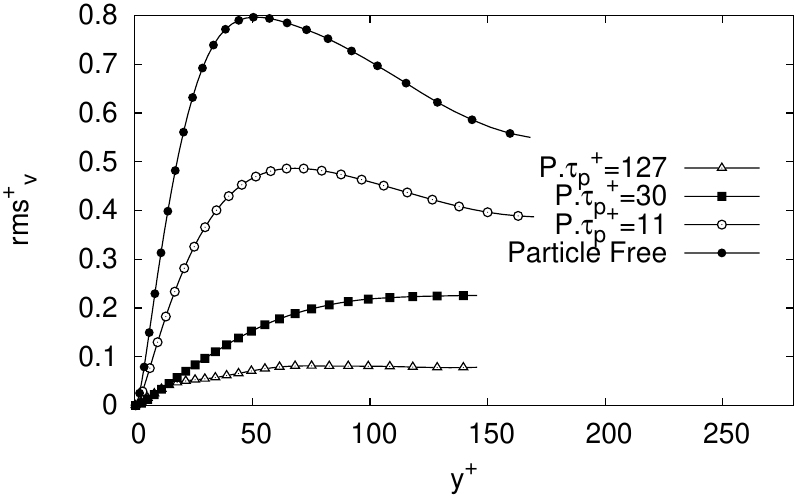
Figure 9. Comparison of rms + v profiles for all production